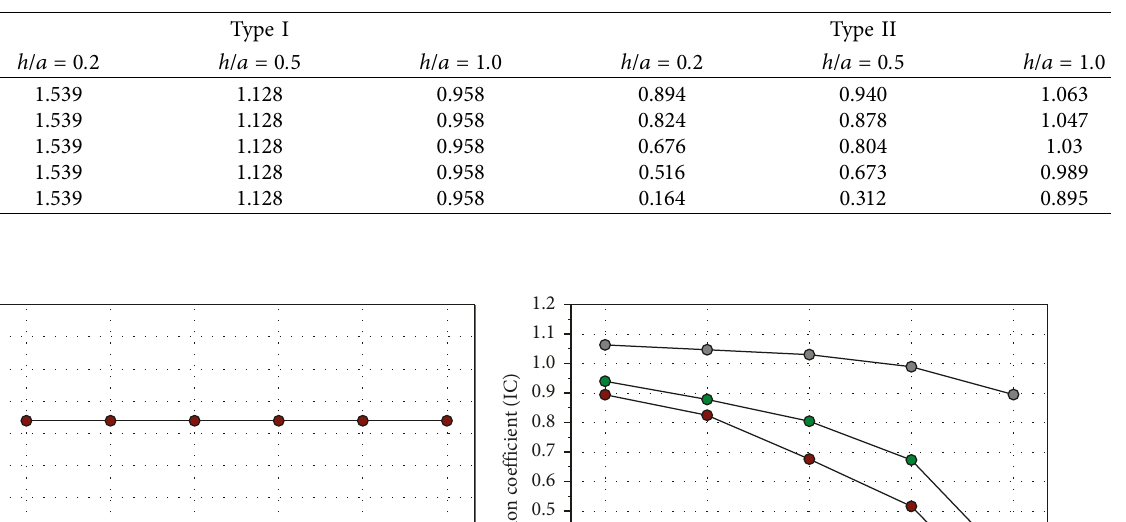
Table 3: ICs varying with crack inclination angle ( α ).